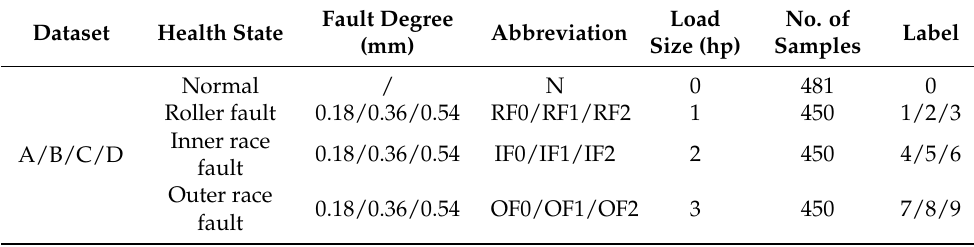
Table 1. Details of the bearing datasets of the diagnosis case 1.